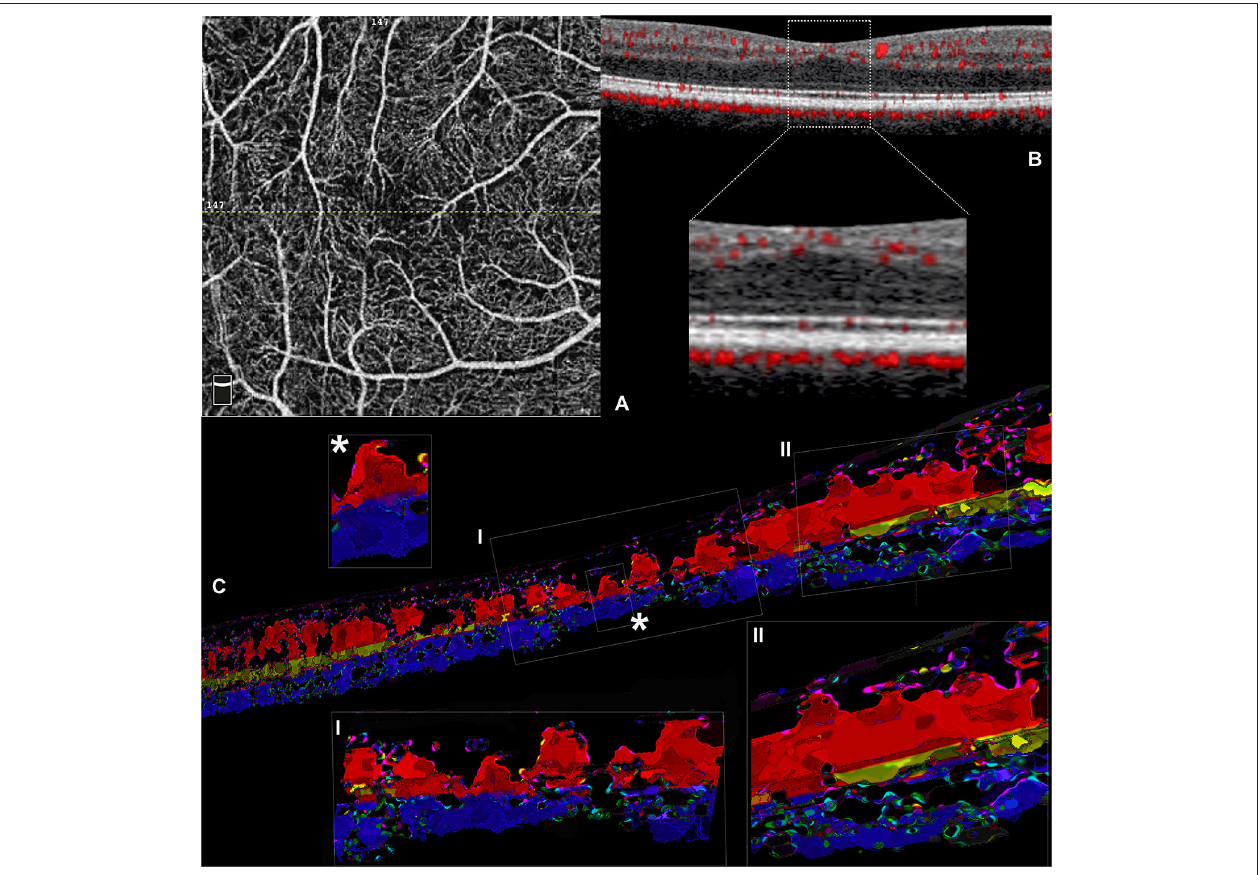
FIGURE 2 | Volume rendering of optical coherence tomography angiography (OCTA) b scans obtained from a case of idiopathic foveal plana (Case 2). (A) En face OCTA slab representing the superficial plexus; the dotted yellow line traces the exact location of the OCTA b scan reported. (B) OCTA b scan demonstrating the distribution of flow signal with no detectable ICP in the central region (inset). (C) Three-dimensional reconstruction obtained from consecutive central OCTA b scans. Inset I with further magnification (*) shows the existence of several shortest path connections between SVC and DCP within the central 0.5mm. However, the regular three-vascular-plexus organization is recovered at the level of parafovea, where the interconnections between SVC and ICP are well